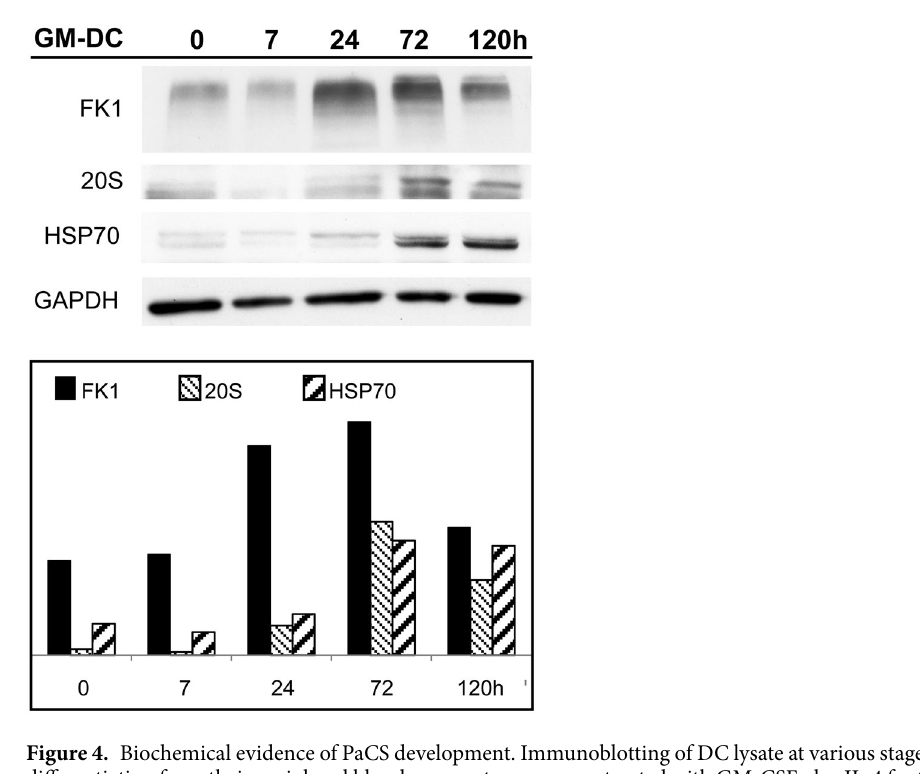
Figure 4. Biochemical evidence of PaCS development. Immunoblotting of DC lysate at various stages of differentiation from their peripheral blood monocyte precursors treated with GM-CSF plus IL-4 for 0–5 days. The histogram shows FK1, 20S and Hsp70 quantitation normalized for protein loading (GAPDH). Note the increment in the levels of FK1-reactive polyubiquitinated proteins and 20S proteasomes starting from 24 h and that of Hsp70 starting from day